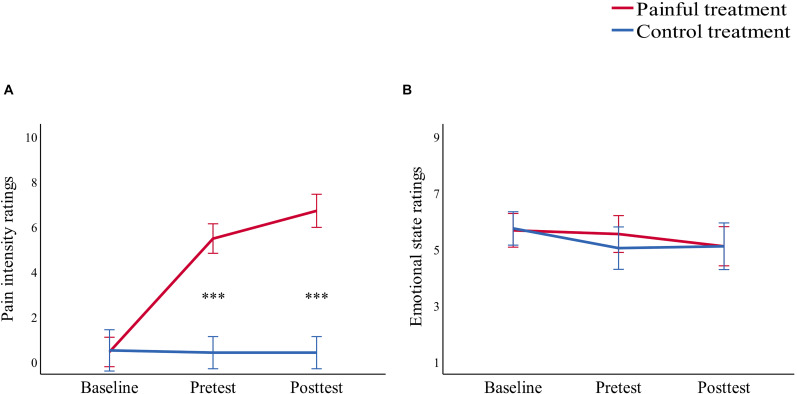
Line charts describing (A) pain intensity ratings and (B) emotional state ratings before treatment (baseline), 15 min after treatment (pretest), and after the study (posttest) in the painful (red line) and control (blue line) treatments. Data are expressed as mean ± standard error of the mean, ***p < 0.001.